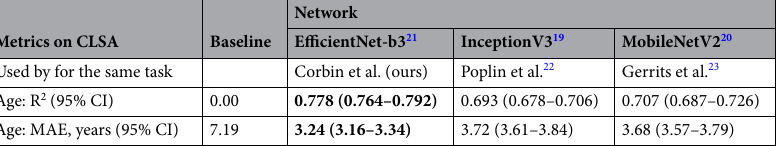
Table 3. Effect of architectures on the mean absolute error (MAE) and the coefficient of determination R 2 . 95% on predicted age. CIs on metrics were calculated with 2000 bootstrap samples the size of the test set. Baseline metrics are from predicting the mean value for all individuals. Significant values are in bold.